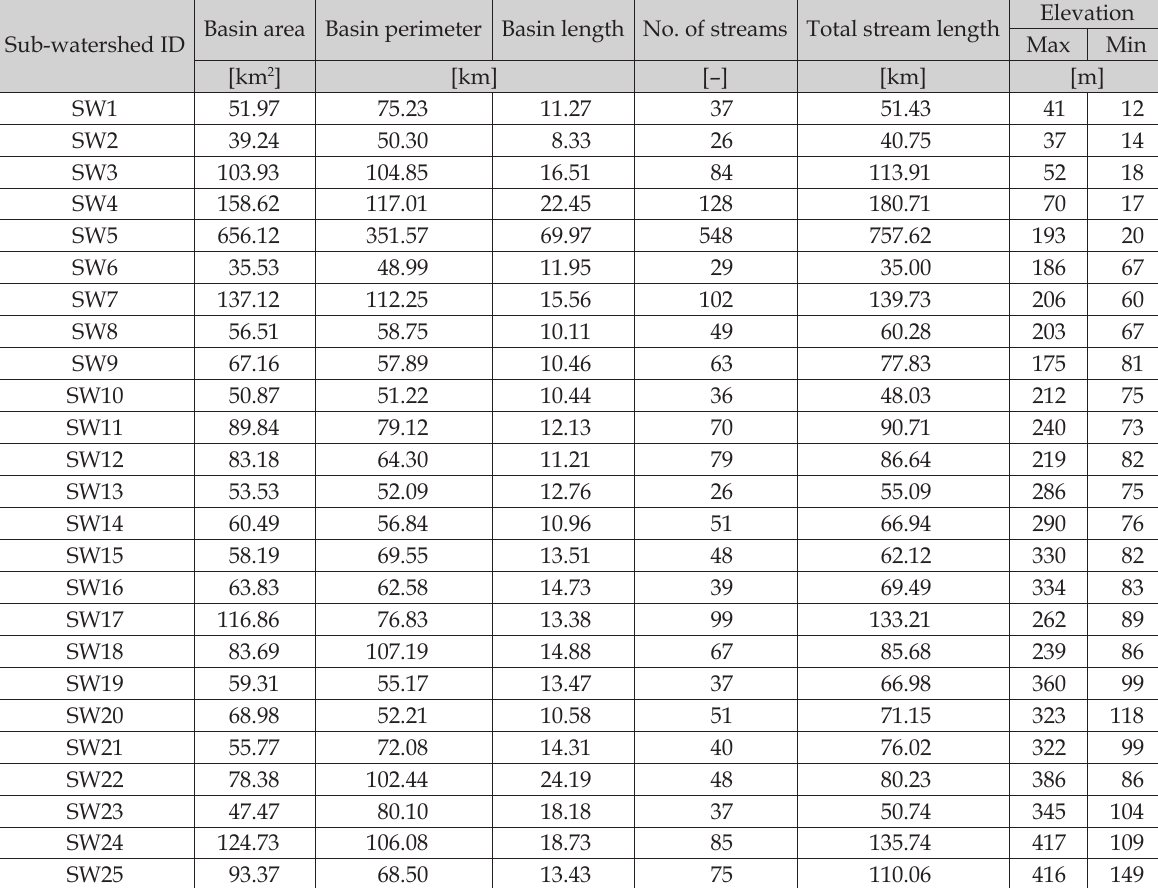
Table 4. Basic parameters of sub-watersheds (SWs) in the Imo River